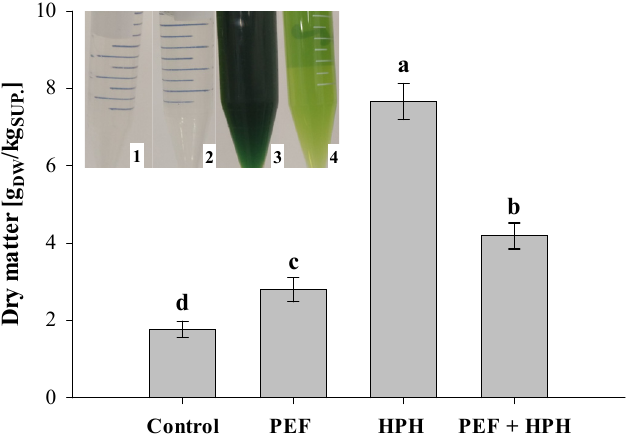
Figure 4. Dry matter content of aqueous supernatants from C. vulgaris suspensions untreated and treated by PEF alone, HPH alone, and with the combination of PEF + HPH. Different letters above the bars indicate significant differences among the samples ( p ≤ 0.05). Insert shows the pictures of aqueous supernatants obtained after centrifugation of microalgae untreated (1) and treated by PEF alone (2), HPH alone (3), and PEF + HPH (4).